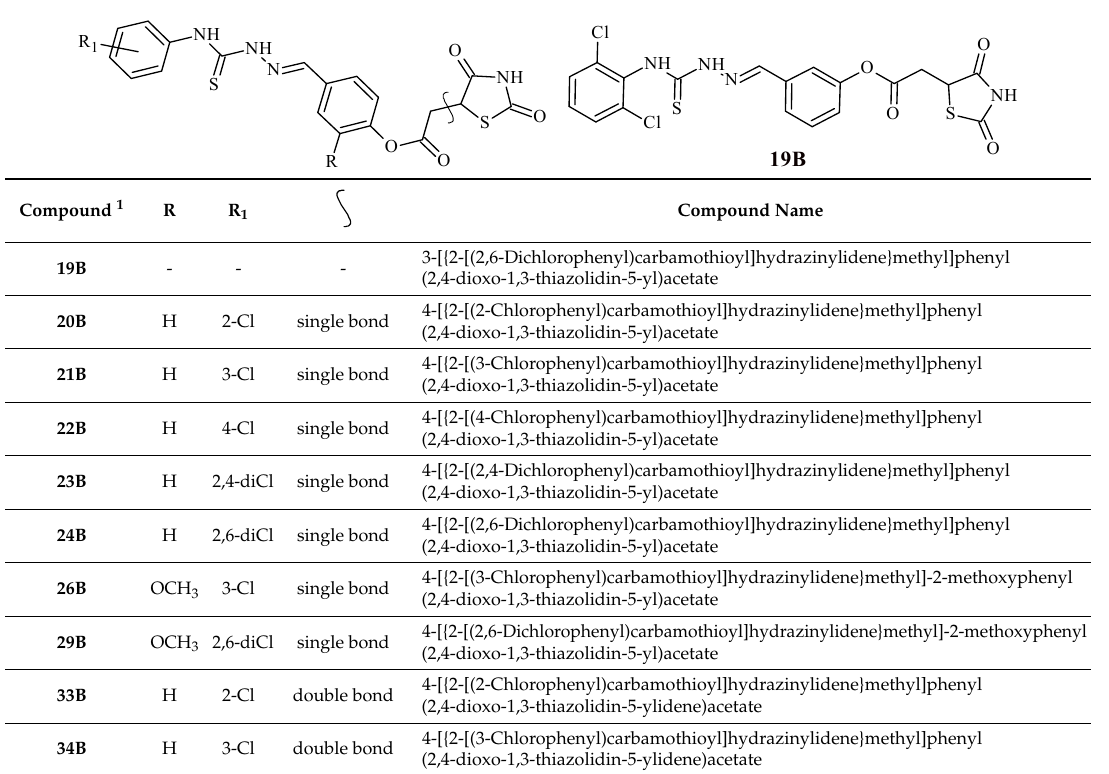
Compound 1 Compound 1 R 1 Compound